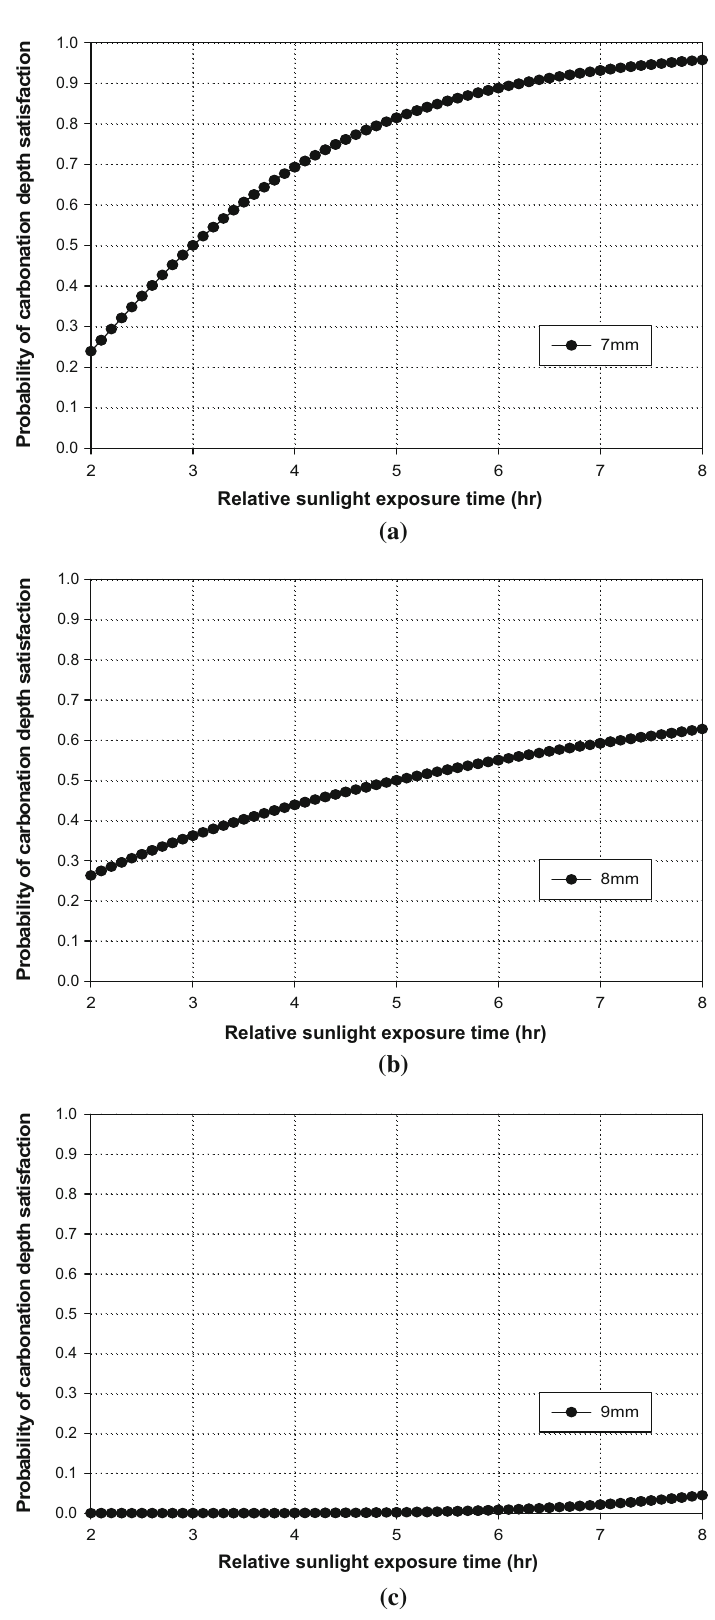
Fig. 5 Satisfaction curve of sunlight exposure time parameter for carbonation depth. a 7 mm, b 8 mm, c 9